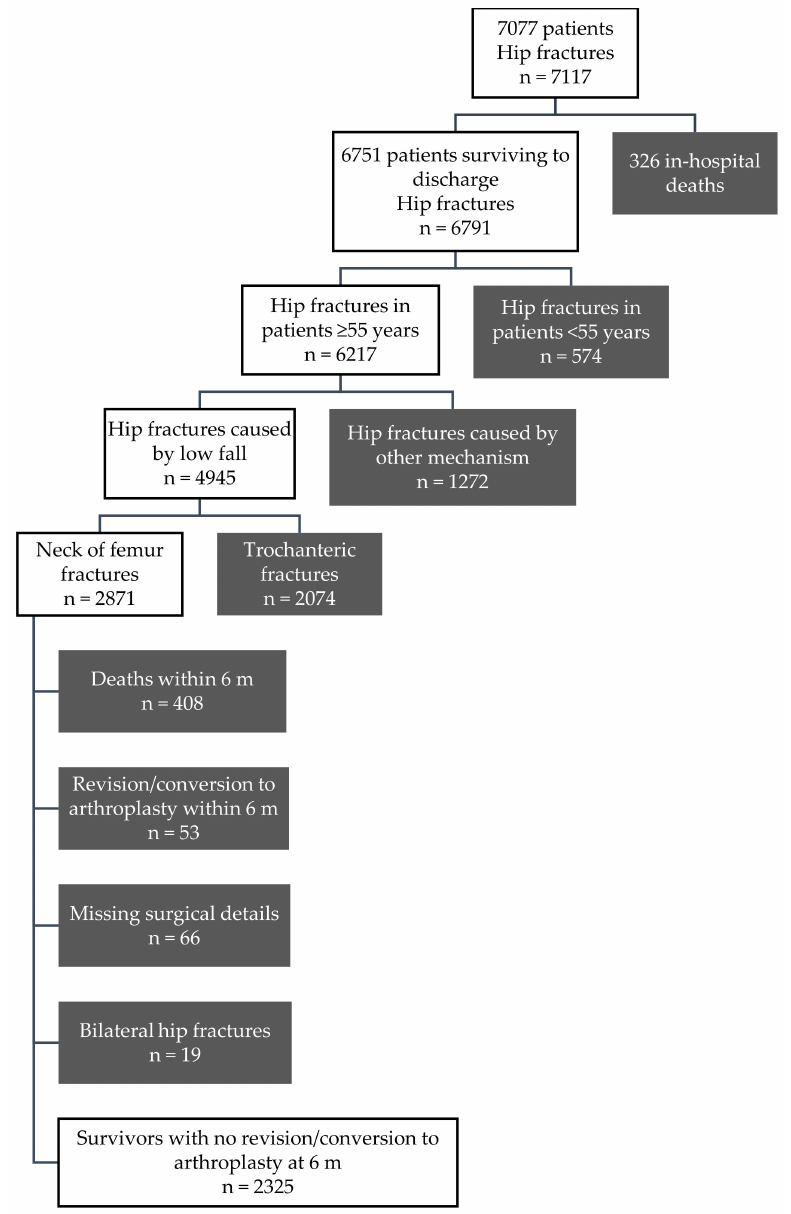
Figure 1. Participant and hip fracture flow chart; m: months after index